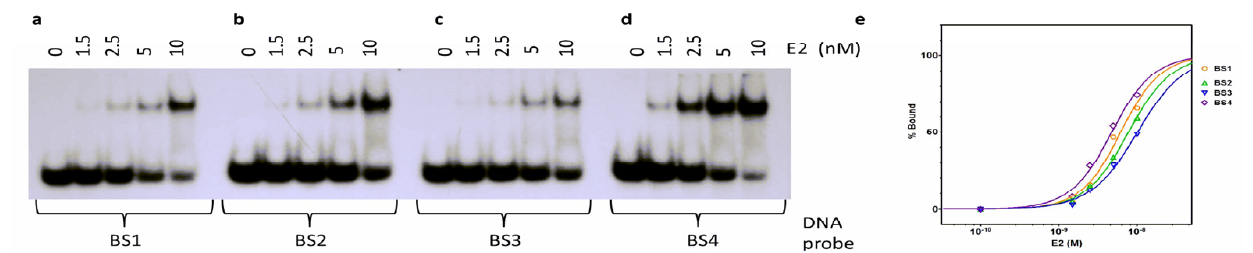
Figure 3. Di ff erential binding of E2 protein to its four binding sites. ( a – d ) E2 protein titration to each of the four binding site probes (Table 1) labeled with 32 P. The E2 protein concentrations were as indicated. ( e ) Results of quantitative analysis of E2 binding to BS1, BS2, BS3, and BS4 as shown in ( a ). Data represent the average of three experiments.